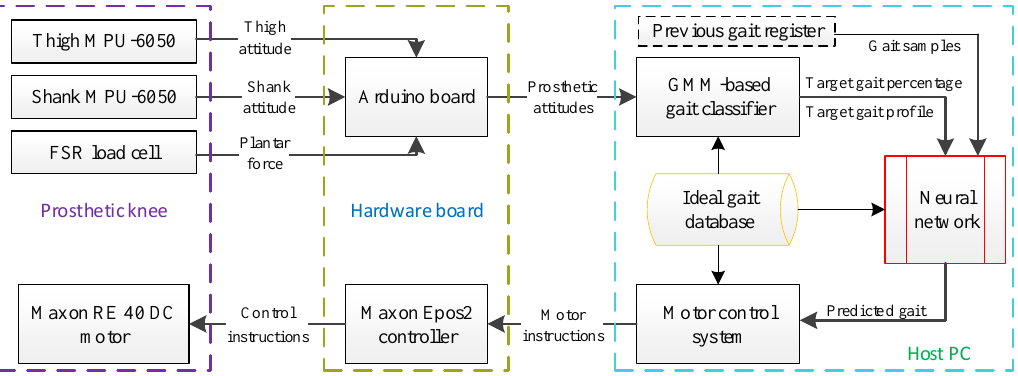
Figure 8. Following control strategy of the powered GFB prosthetic knee.